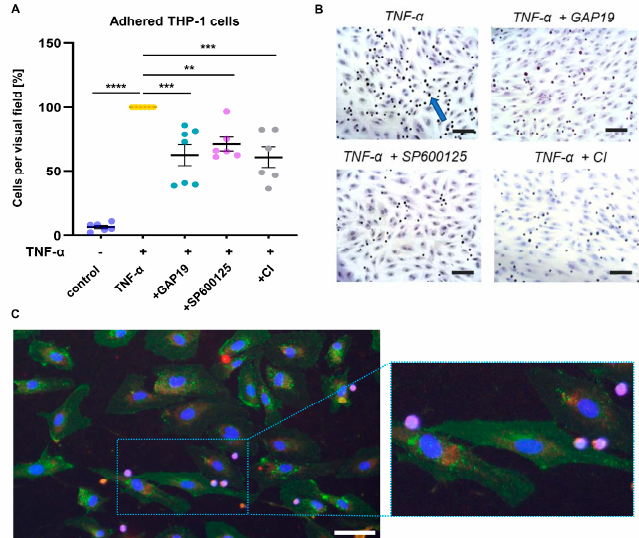
Figure 4. Cx43 and caspase 3 induction are involved in proatherogenic cell responses of HUVECs exposed to non-uniform SS. Cell adhesion assay was performed following 20 h of SS exposure. After 18 h of perfusion with medium, HUVECs were perfused with medium, TNF- α or TNF- α together with an inhibitor of Cx43 (GAP19) or of JNK1/2 (SP600125) or a caspase inhibitor (CI) for 2 h, followed by 1 h of perfusion with THP-1 monocytes. Cells were stained and microscopic images in regions of laminar SS (6 per slide) and non-uniform SS (8 per slide) were obtained. Mean numbers of adherent THP-1 cells per visual field were assessed in laminar and non-uniform SS regions ( A ) and compared to TNF- α treatment, which was set to 100%. Comparable to SP600125, incubation with GAP19 or CI together with TNF- α resulted in lower adhesion of THP-1 cells to the HUVEC monolayer than sole TNF- α . Data are presented as mean ± SEM, dots represent values from individual experiments, n = 6–7, analyzed by one-way ANOVA followed by Sidak’s multiple comparison. ( B ) Shown are exemplary microscopic images of monocytes (blue arrow) adhered to the endothelial cell monolayer under nun-uniform SS. Scale bar = 100 µm. ( C ) Immunofluorescent staining of Cx43 and Cx40 was performed following adhesion assay and fluorescence microscopic images were obtained in regions of non-uniform SS. Exemplary images show THP-1 monocytes (violet), which have adhered to the endothelium (DAPI = blue, Cx43 = green, Cx40 = red; bar represents 50 µm). ** p < 0.01, *** p < 0.001, **** p < 0.0001.